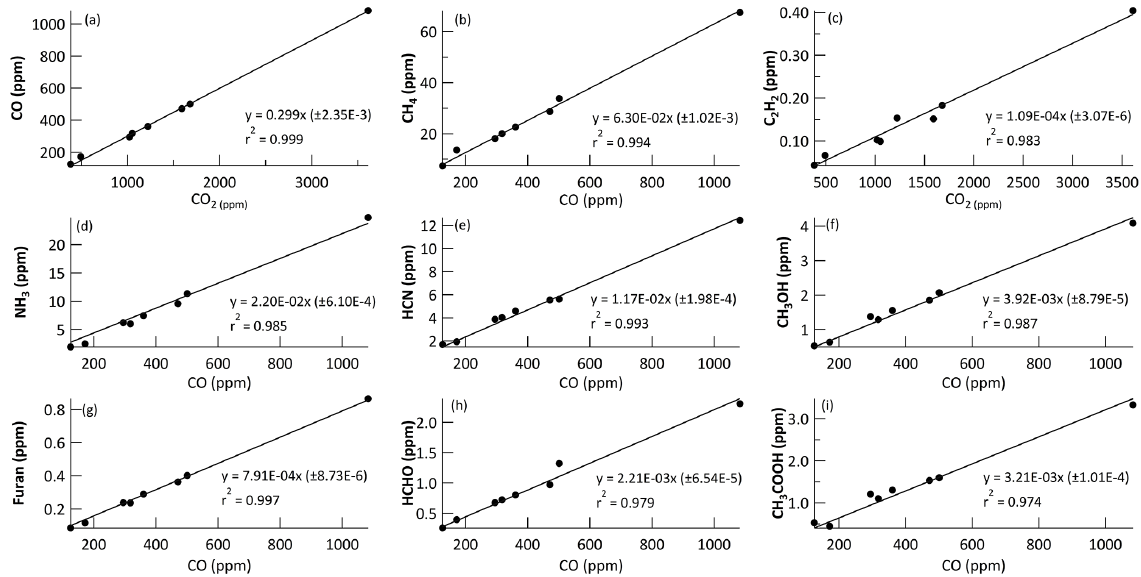
Figure 1. ER plots from plume N for (a) carbon monoxide, (b) methane, (c) acetylene, (d) ammonia, (e) HCN, (f) methanol, (g) furan, (h) formaldehyde, and (i) acetic acid measured by